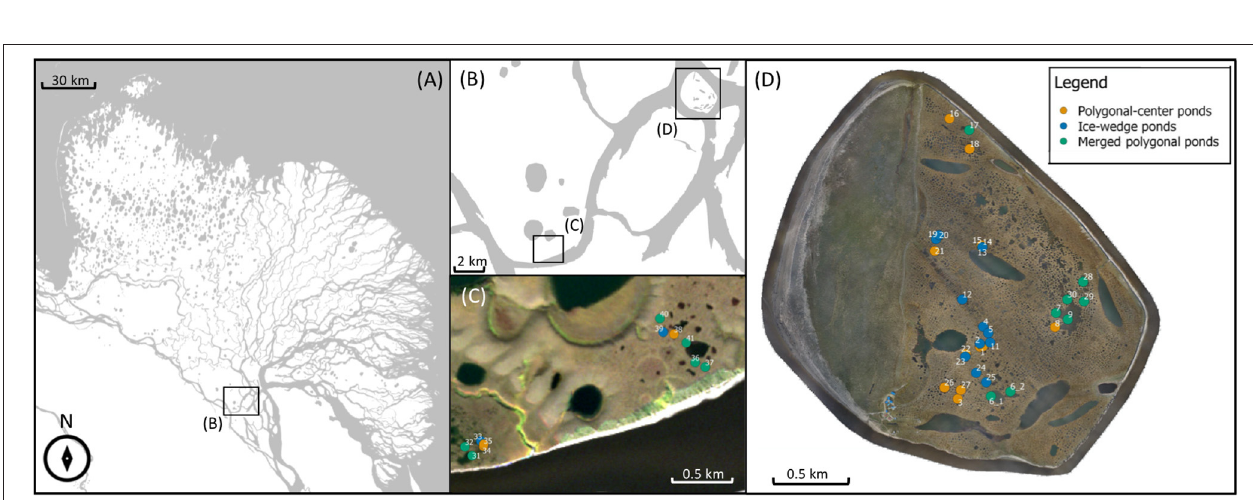
FIGURE 1 | Schematic of the different pond types in the polygonal tundra. Ice-wedge ponds form along the edges of polygons on top of ice wedges, have a frozen bottom and have often an elongated shape and a steep slope. Polygonal-center ponds form in between ice wedges, in the center of the polygons. They tend to be nearly circular. If several polygons subside, merged polygonal ponds form. These ponds are the largest pond type of the three.